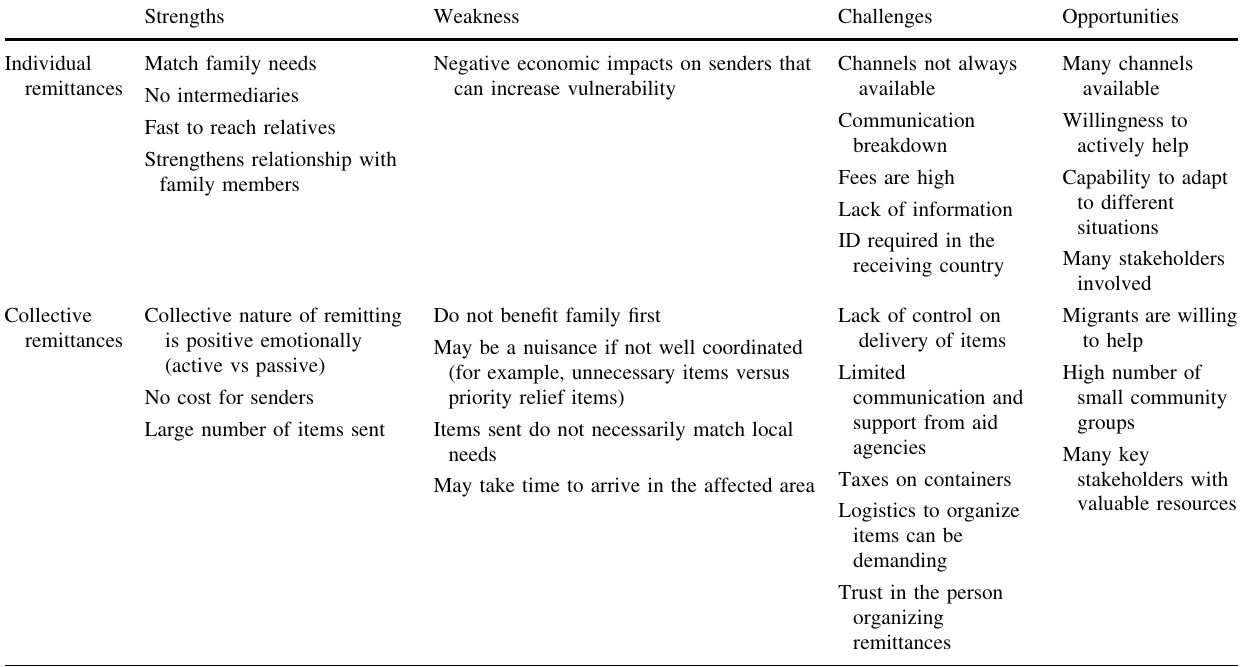
Table 1 Case study of remittance issues for Pacific Island migrants to New Zealand, January 2017–March 2017. Individual and collective remittances: strengths, weaknesses, challenges, and opportunities ( n = 37)